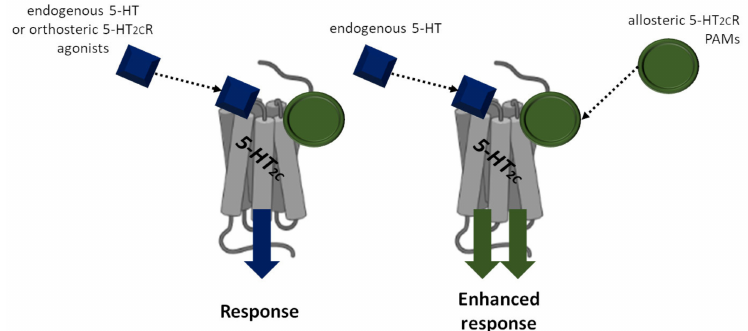
Figure 1. Mechanisms of the 5-HT 2C R function modulation by agonists and positive-allosteric modulators (PAMs). The 5-HT 2C R agonists bind to the same orthosteric sites as endogenous serotonin (5-HT) at the 5-HT 2C R to evoke a response. Opposed to the 5-HT 2C R agonists, the 5-HT 2C R PAMs bind to allosteric sites at the 5-HT 2C R, enhancing the affinity and efficacy of the 5-HT 2C R response by